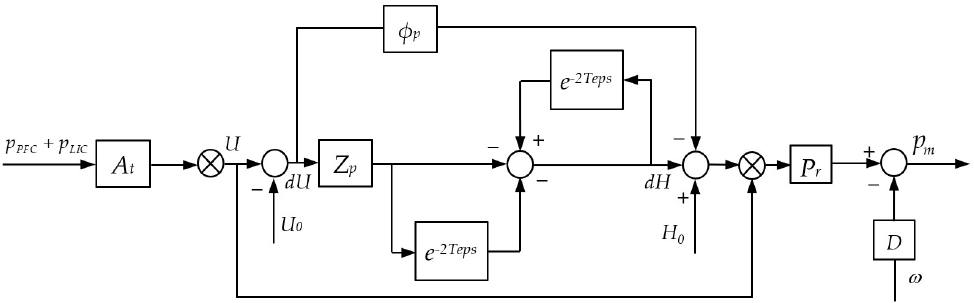
Figure 6. Detailed model of the prime